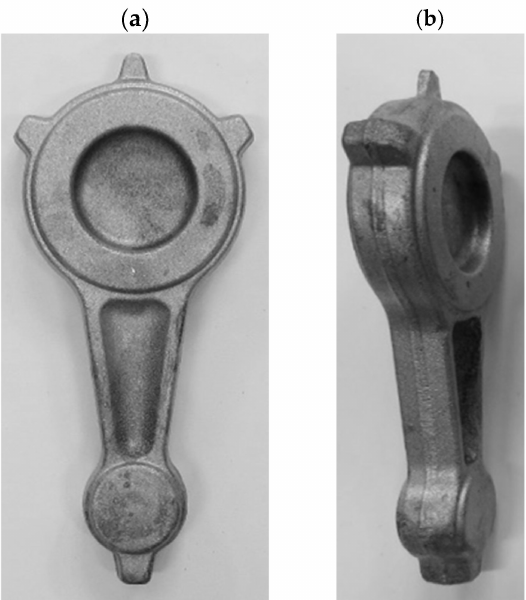
Figure 28. Forgings of connecting rods made of AB-71100 aluminum alloy after trimming the flash and etching process obtained from cast preforms in accordance with variant 1: ( a ) top view; ( b ) side view.